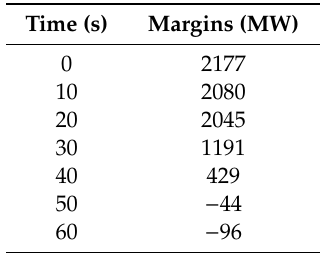
Table 2. Specific margins with each PV curve.